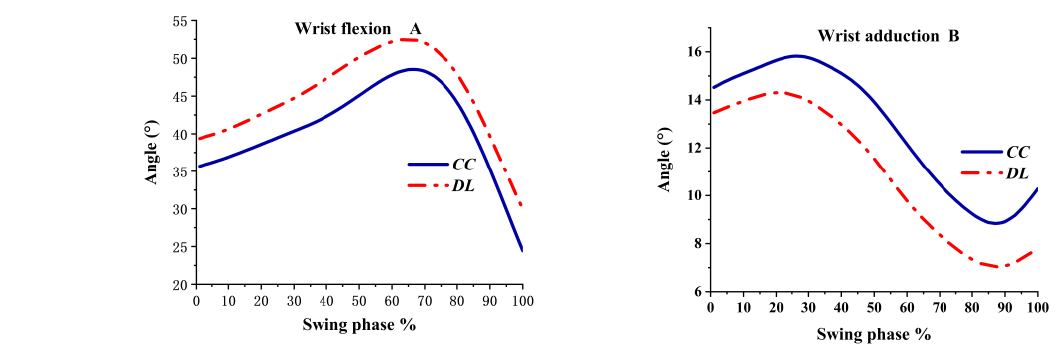
Figure 4. Elbow angles during the swing phase. The angle of the shoulder in the sagittal plane was flexion. Flexion had a steady rise at the beginning of the swing phase, as shown in Figure 5A. A greater shoulder abduction angle was observed in DL than CC during the whole swing phase, as shown in Figure 5B. The abduction angle in the shoulder was increased and reached the maximum at 80 % of the swing phase, and the abduction angle gradually decreased before the impact. The shoulder in the transverse plane was an internal rotation angle, which reached the peak before the impact, which was 70% of the swing phase, then decreased slowly, as shown in Figure 5C. Figure 5. The shoulder angles during the swing phase.